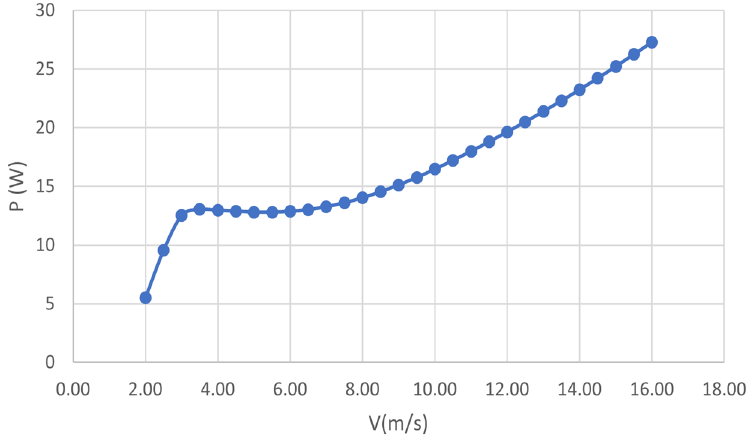
Figure 8. Power ( W ) vs. wind speed (m/s) for 3 blades of VAWT.